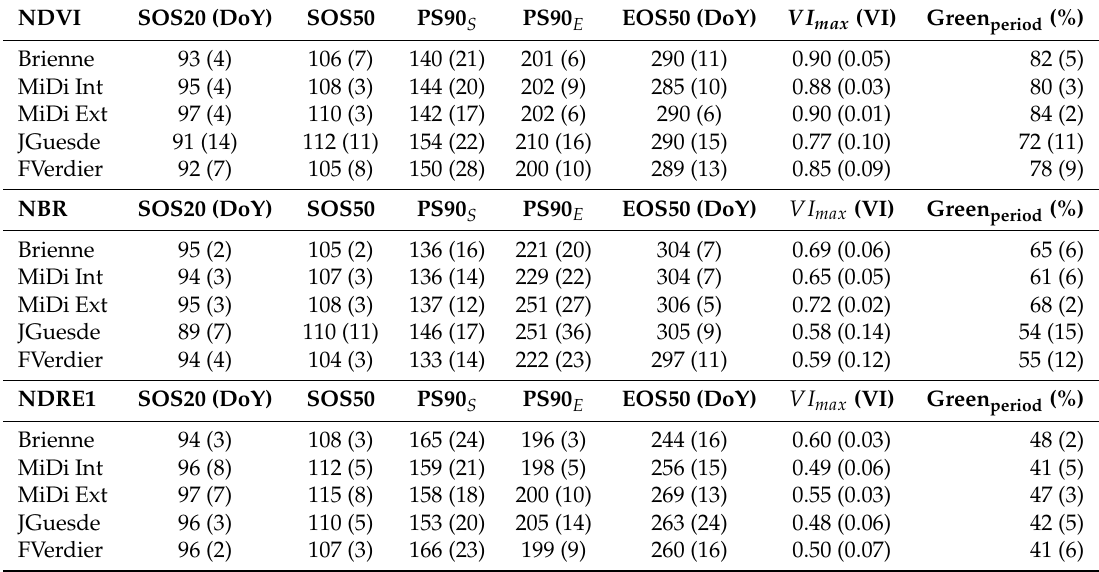
Table 3. Mean of the annual phenological dynamics criteria on S-G filtered phenological curves for NDVI, NBR and NDRE1 and for the five studied areas. Standard deviations are indicated within